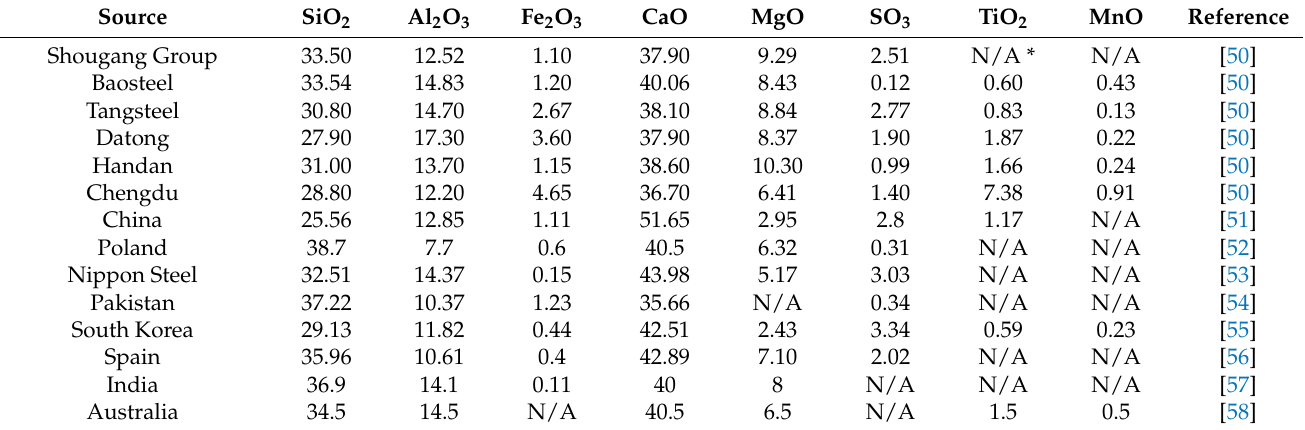
Table 1. Chemical ingredients of granulated blast-furnace slag and their sources (wt